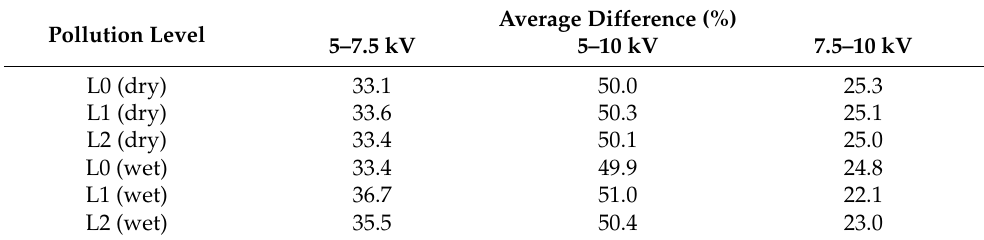
Table 5. Comparison of differences in leakage current for various voltage levels.